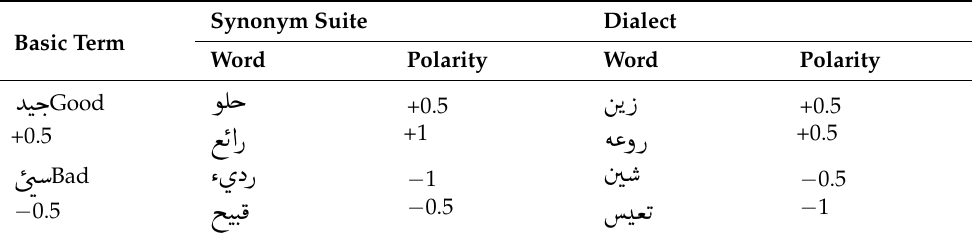
Table 3. An illustration of how a LX is constructed.